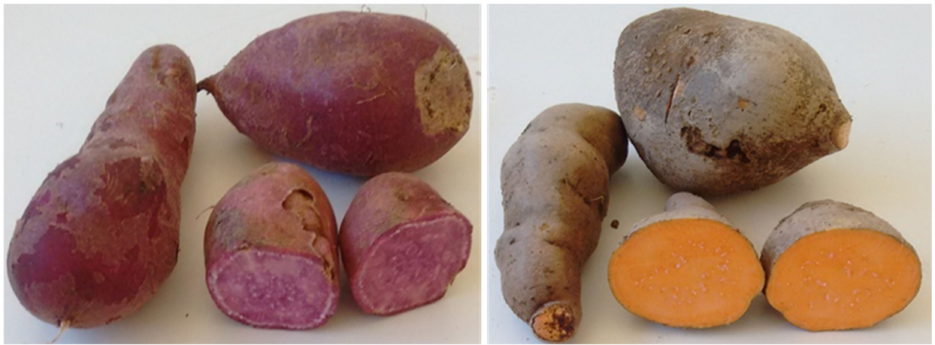
Figure 2. Purple and orange-fleshed sweet potatoes. Source: